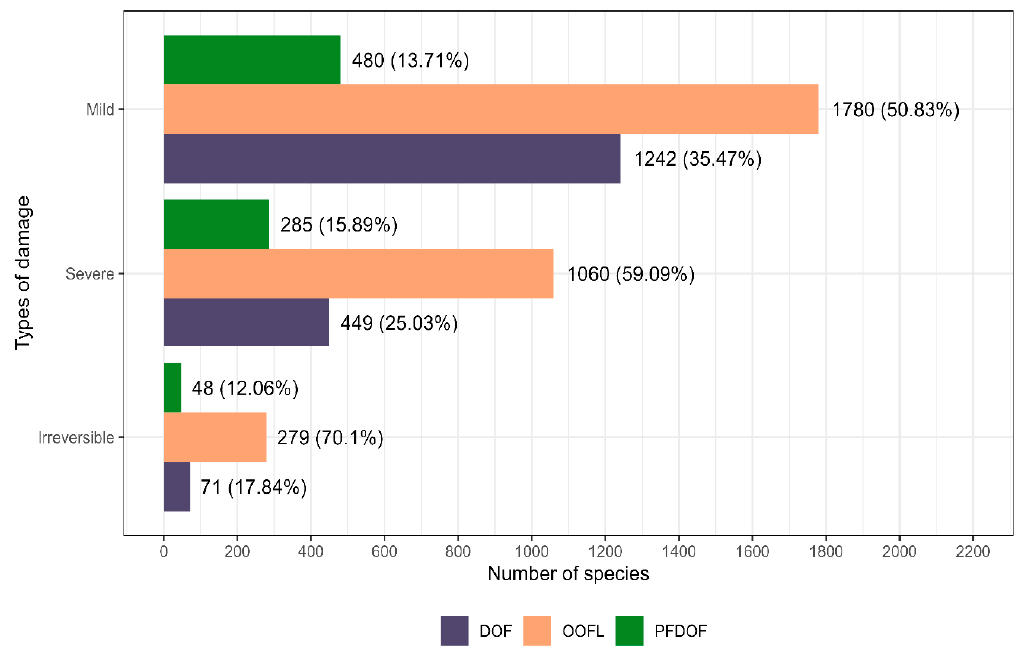
Figure 4. Proportion and number of mild, severe, and irreversible damages by phytophysiognomy. PFDOF: periodically flooded dense ombrophilous forest; DOF: dense ombrophilous forest; OOFL: open ombrophilous forest with lianas.